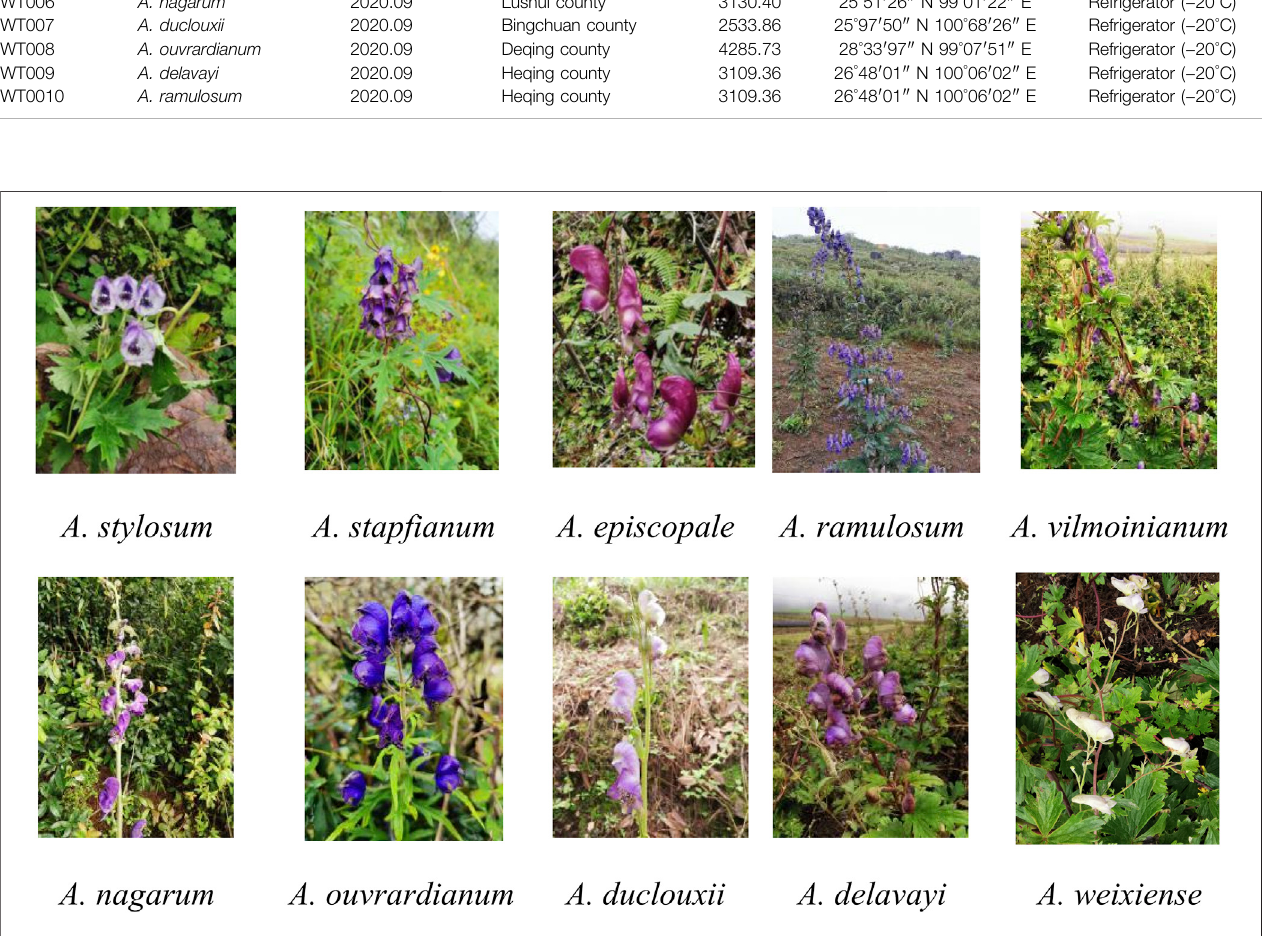
FIGURE 1 | Pictures of original plants of ten Aconitum